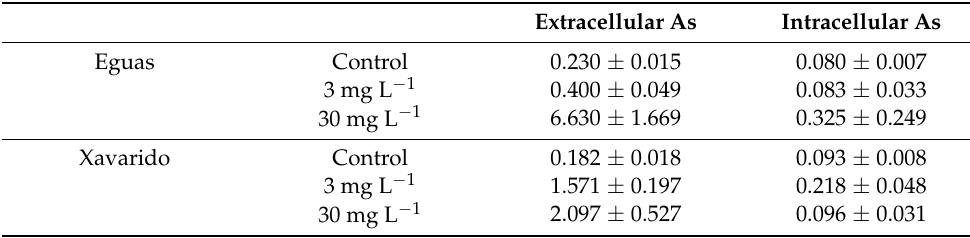
Table 4. Total extracellular and intracellular As (mg kg − 1 ) at the end of Experiment 1 in Eguas and Xavarido systems (mean ± SD, n = 3).